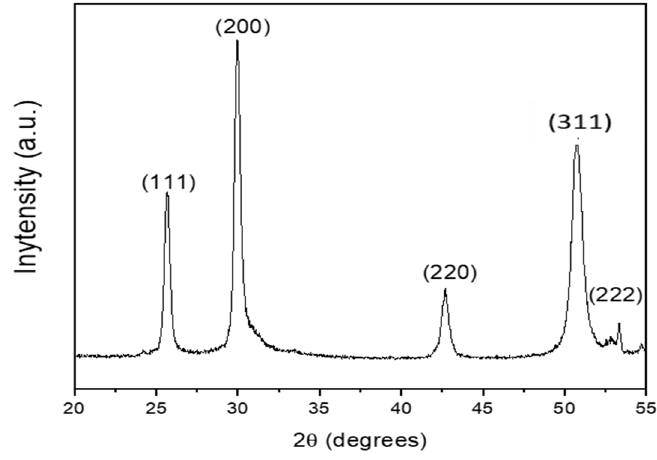
Figure 2. XRD diagram of PbS crystals PLD-deposited at room temperature on intrinsic (100) oriented silicon.